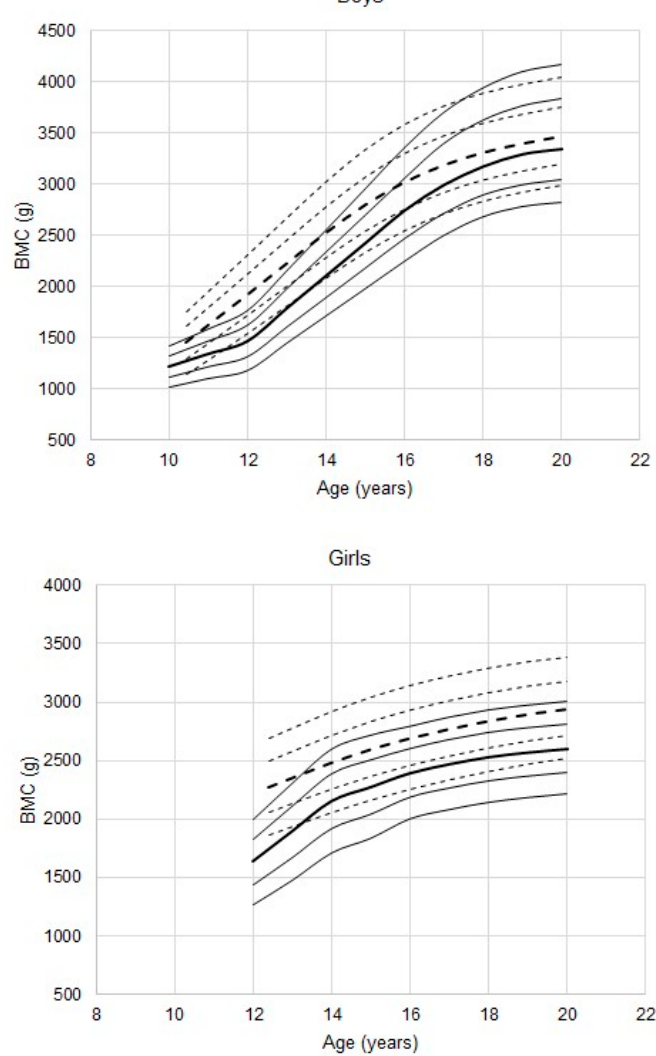
Figure 3. Total BMC in youth male and female athletes 11 to 20 years of age; percentiles (- - -) for athletes, estimated with the LMS method, are plotted relative to the DEXA reference (—) percentiles (10th, 25th, 50th, 75th, 90th; the 50th percentiles are in bold).